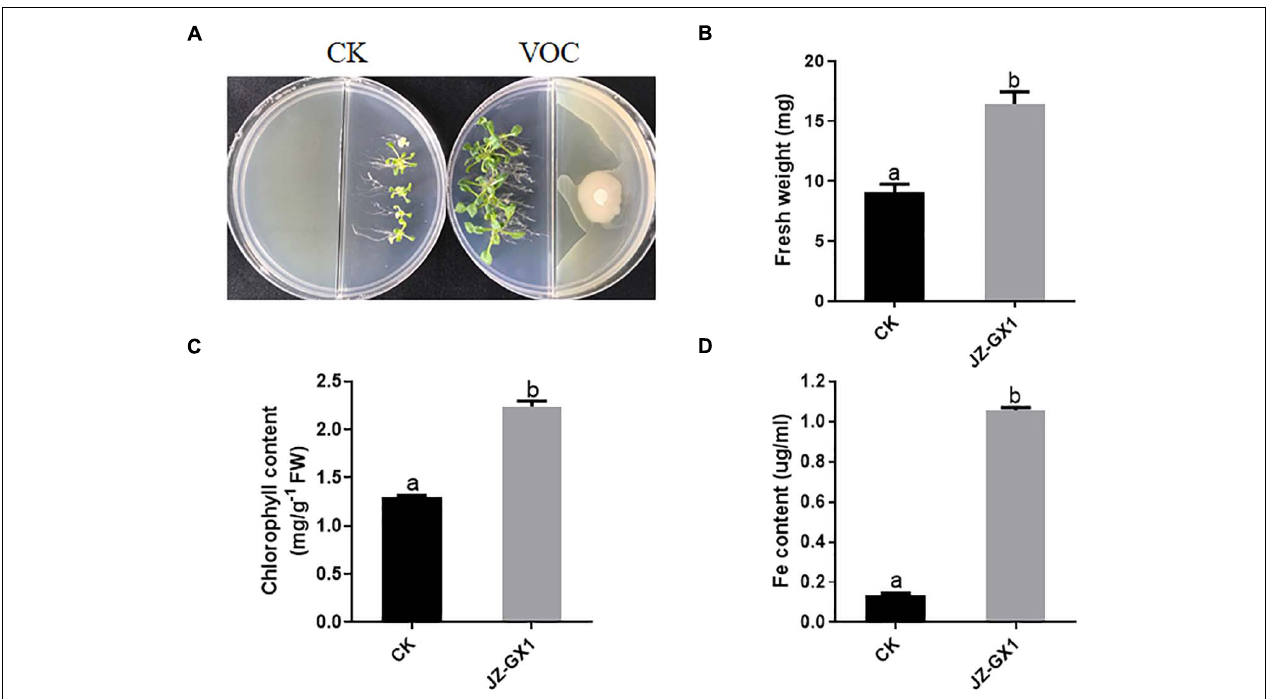
FIGURE 1 | Effects of VOCs of Rahnella aquatilis JZ-GX1 on the growth of Arabidopsis thaliana under iron limitation. (A) Plant phenotype, (B) plant fresh weight, (C) chlorophyll content, and (D) active iron content. CK: control. One-way ANOVA was performed, and Duncan’s post hoc test was applied. Different letters indicate statistically significant differences ( p < 0.05) among